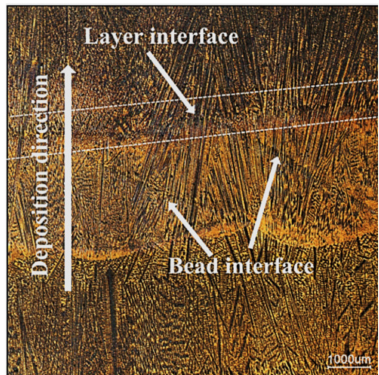
Figure 19. Microstructure in the interlayer of sample. Reprinted from Ref. [63].